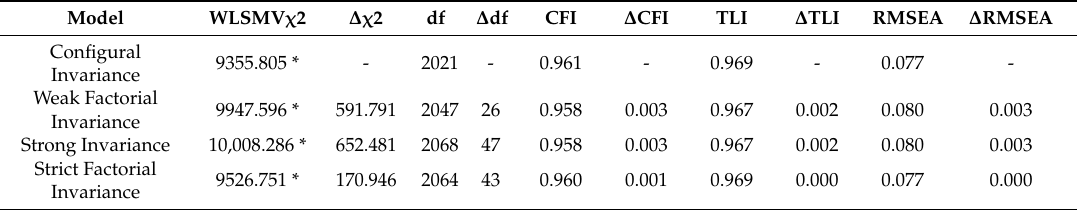
Table 5. Multigroup analysis of the structural model across all